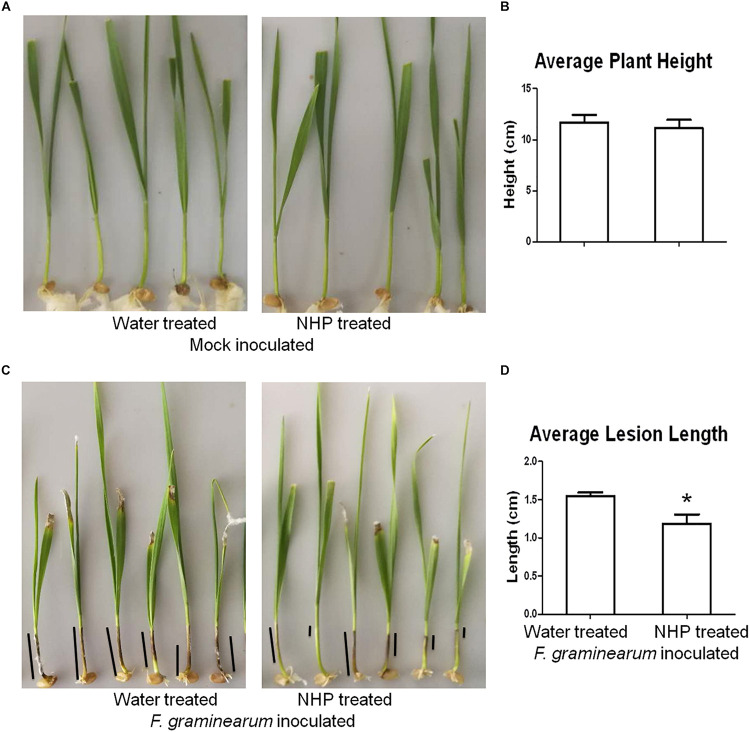
Representative images and measurements of wheat seedlings treated with water or N-hydroxypipecolic acid (NHP). (A,B) Mock-inoculated seedlings. (C,D)
F. graminearum-inoculated seedlings. Black lines show examples of lesions on coleoptiles; n = 3 independent experiments. Error bars indicate the SE. An asterisk indicates a significant difference compared with the control (p < 0.05; Student’s t-test).